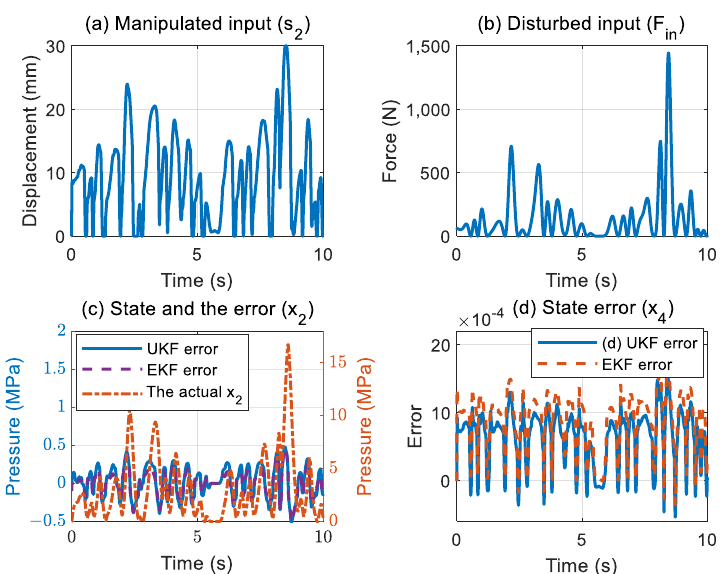
Figure 13. Input and state in closed-loop